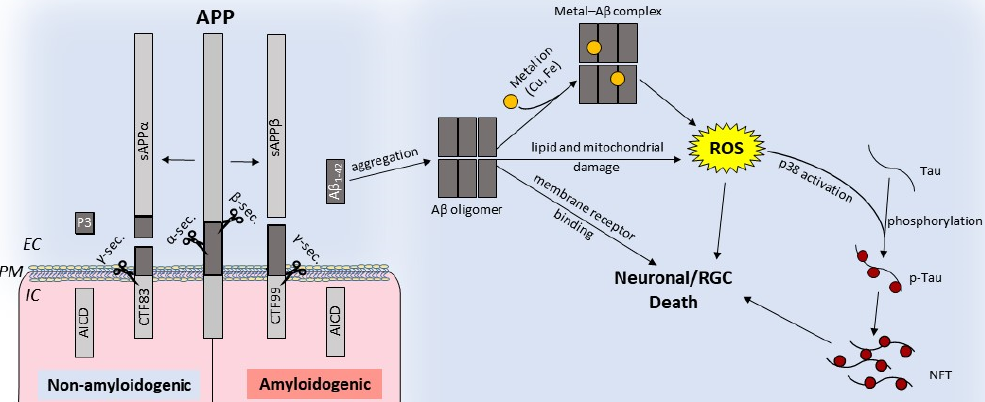
Figure 2. Schematic representation of nonamyloidogenic and amyloidogenic processing of the amyloid precursor protein (APP): nonamyloidogenic processing of APP is mediated by α-secretase followed by γ-secretase, releasing soluble APPα and intracellular fragments AICD and P3. Amyloidogenic processing involves cleavage by β-secretase followed by γ-secretase, which releases toxic Aβ 1−42 [79,80]. Aβ can oligomerize and form cytotoxic metal-Aβ complexes that generate ROS, disrupt the lipid bilayer, compromise mitochondrial function, or initiate aberrant signaling cascades. Activation of p38 by ROS phosphorylates tau results in NFTs. IC: intracellular, EC: extracellular, NFTs: neurofibrillary tangles, and PM: plasma membrane.